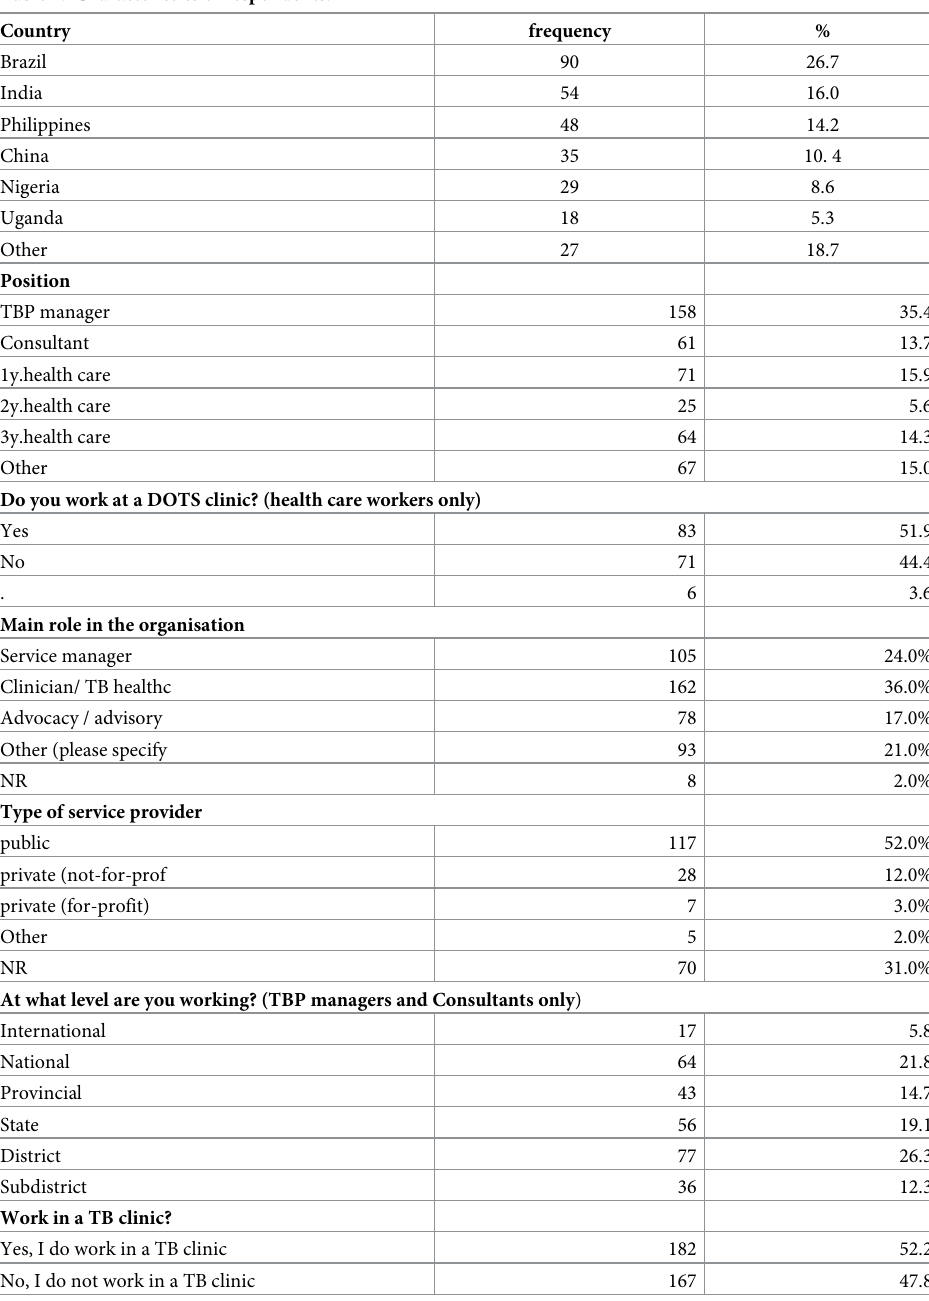
Table 1. Characteristics of